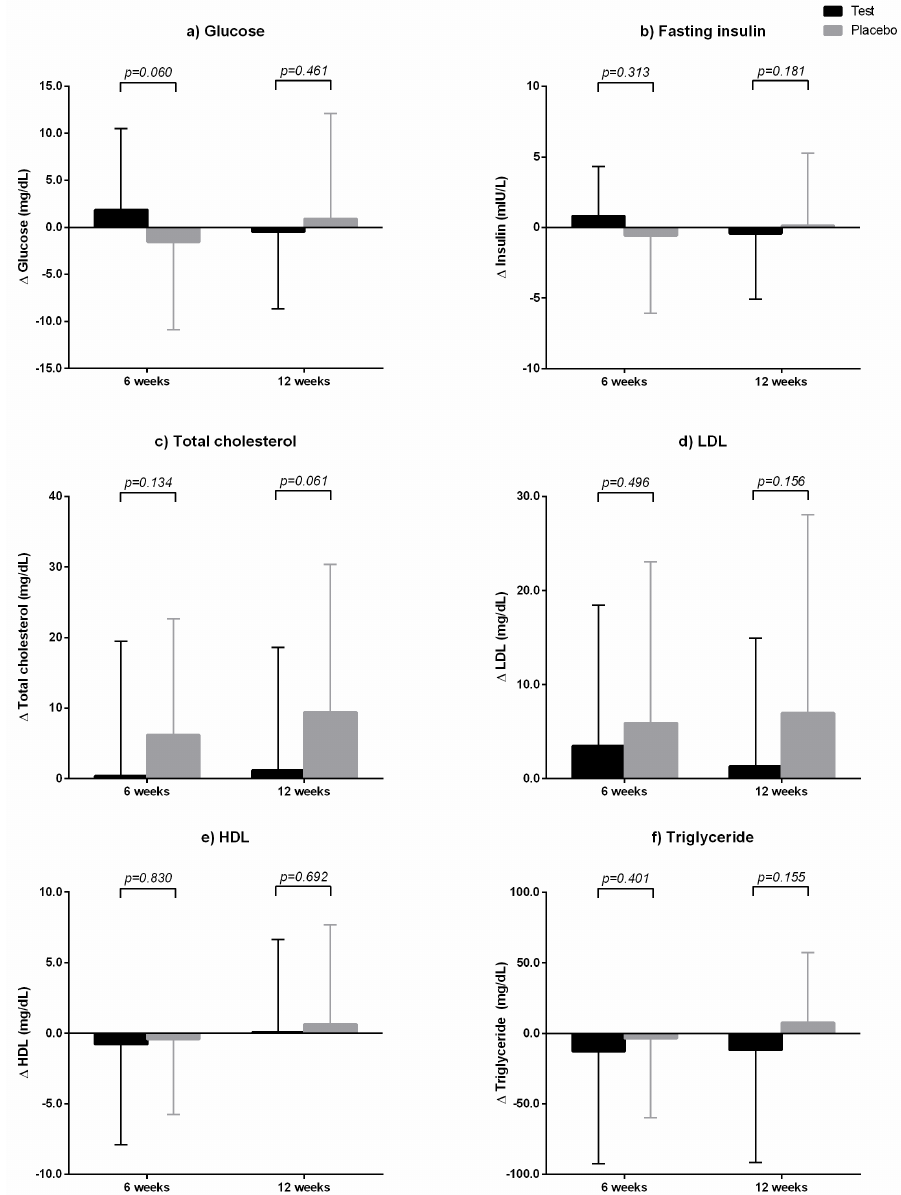
Figure 5. Laboratory changes from baseline between the two groups at six and 12 weeks. The test group was administered Gelidium elegans extract 1000 mg / day for 12 weeks, and the placebo group was administered placebo in a similar manner. ( a ) Glucose; ( b ) fating insulin; ( c ) total cholesterol; ( d ) LDL; ( e ) HDL; and ( f ) triglyceride. p -values were calculated using an ANCOVA test adjusted for baseline value, calorie intake, and physical activity.